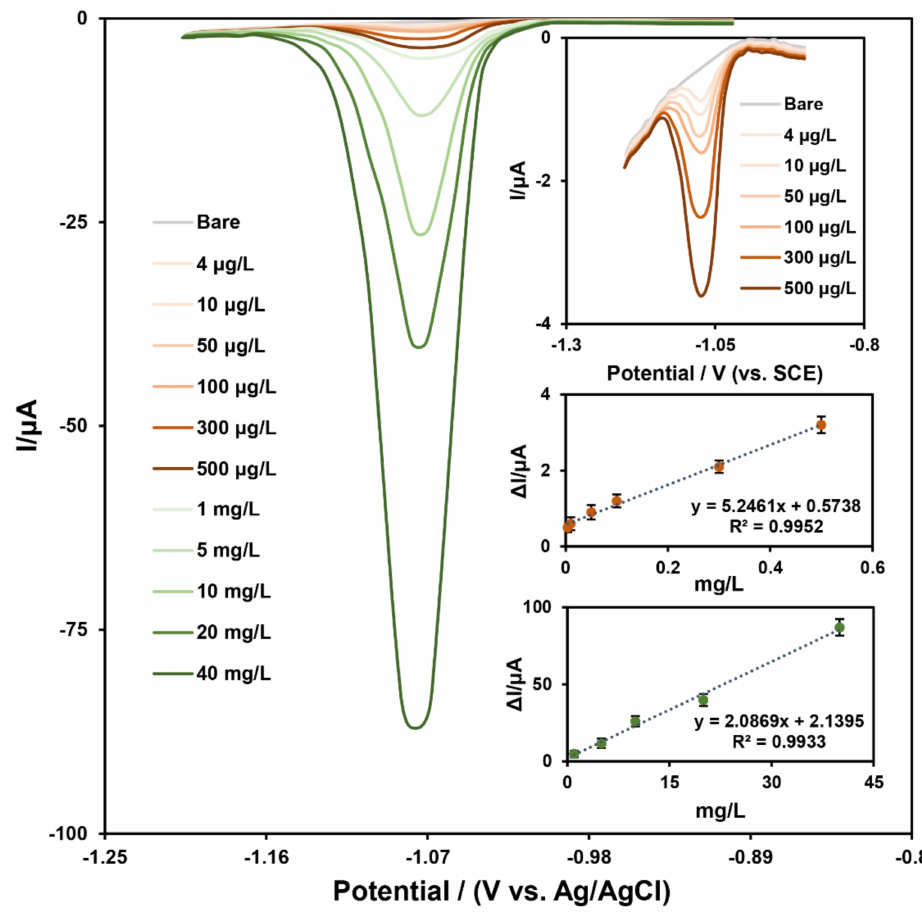
Figure 7. DPV of different concentrations of alprazolam in Britton–Robinson buffer solution (BRB) with a pH of 9.0 (two bottom insets show the calibration curves). (n =